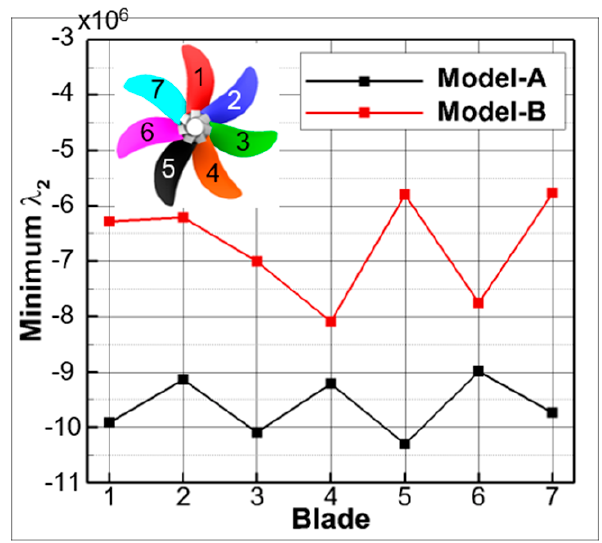
Figure 12. Comparison of minimum λ 2 of each blade between two propellers of Model-A and Model- B.